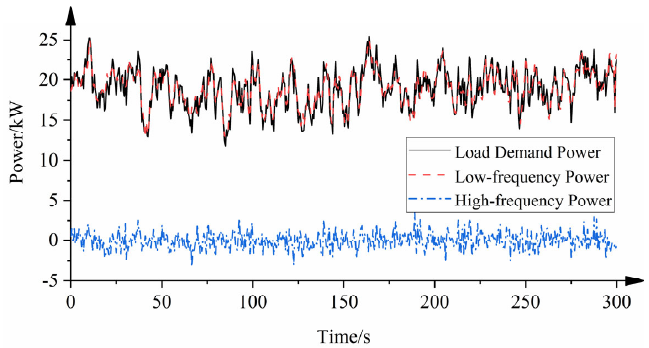
Figure 15. First − layer decoupling results based on the Haar wavelet.